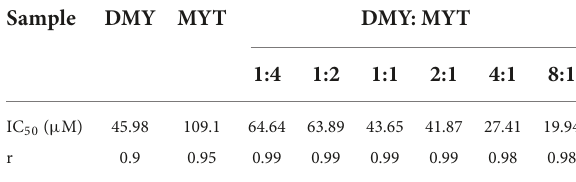
TABLE 2 Half-inhibitory concentration of drugs on B16F10 cell